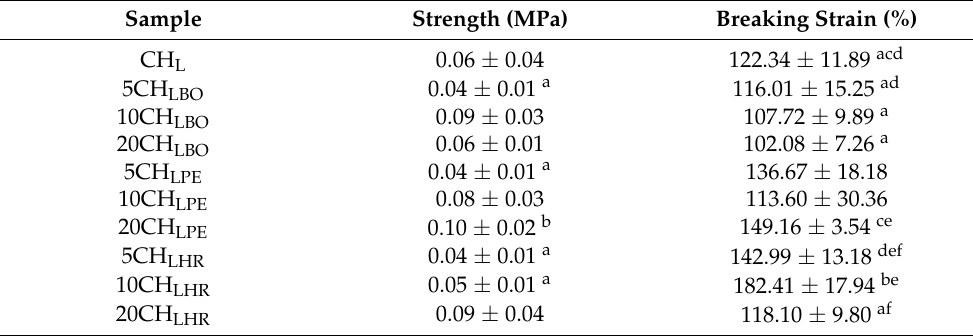
Table 4. Textural properties expressed as strength (MPa) and breaking strain (%). Sample Strength (MPa) Breaking Strain